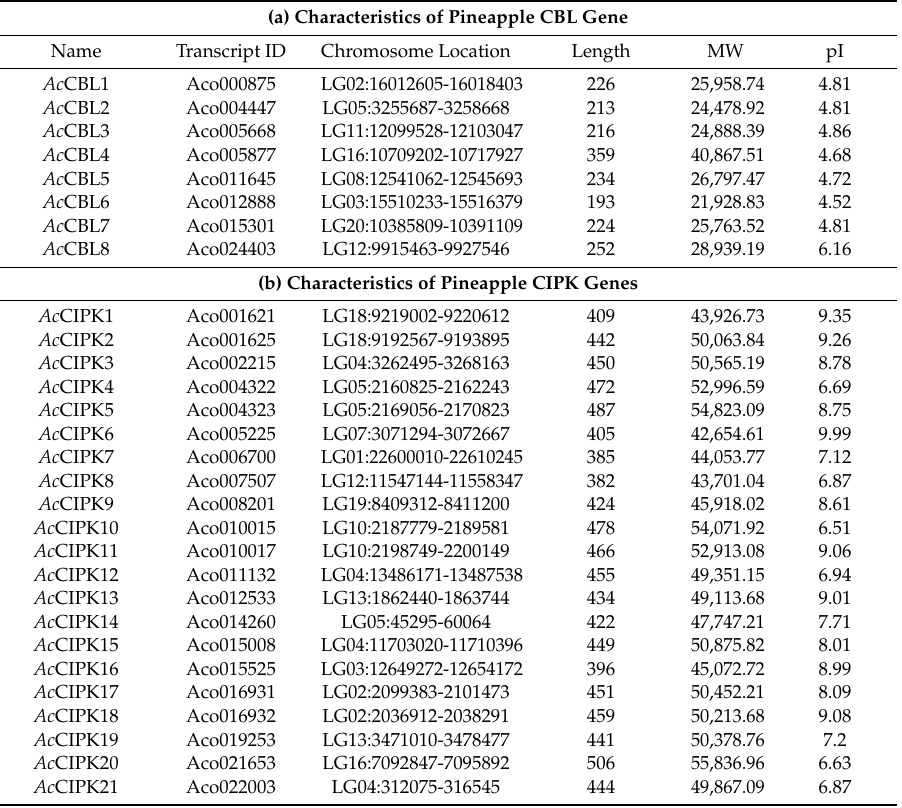
Table 1. Characteristics of calcineurin B-like (CBL) and CBL-interacting protein kinases (CIPK) genes identified from pineapple. Prefix ‘Ac’ Indicates Ananas comosus